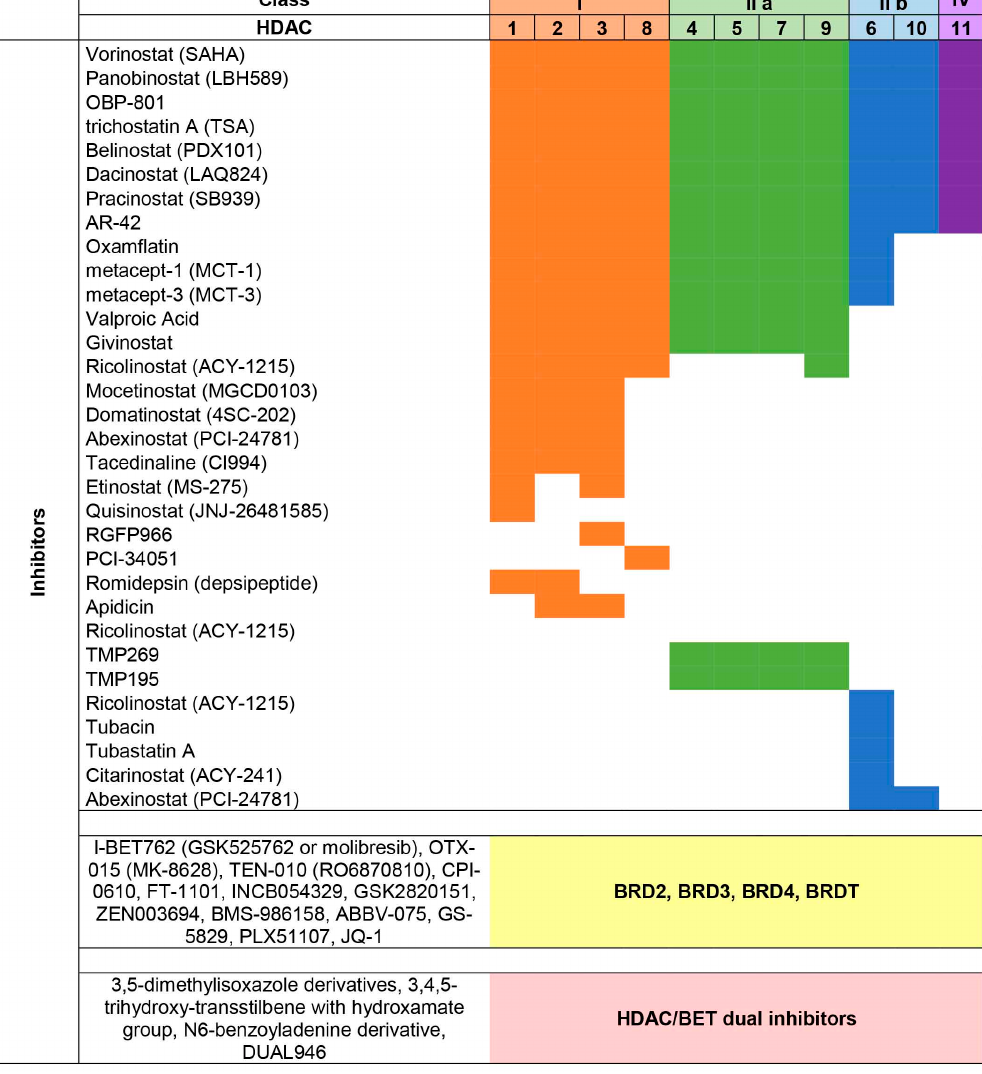
Figure 1. Specificity of various Histone DeACetylase (HDAC) inhibitors for members of the four classes of HDACs. Compounds inhibiting Bromodomain and Extraterminal domain (BET) proteins and dual inhibitors are also showed.